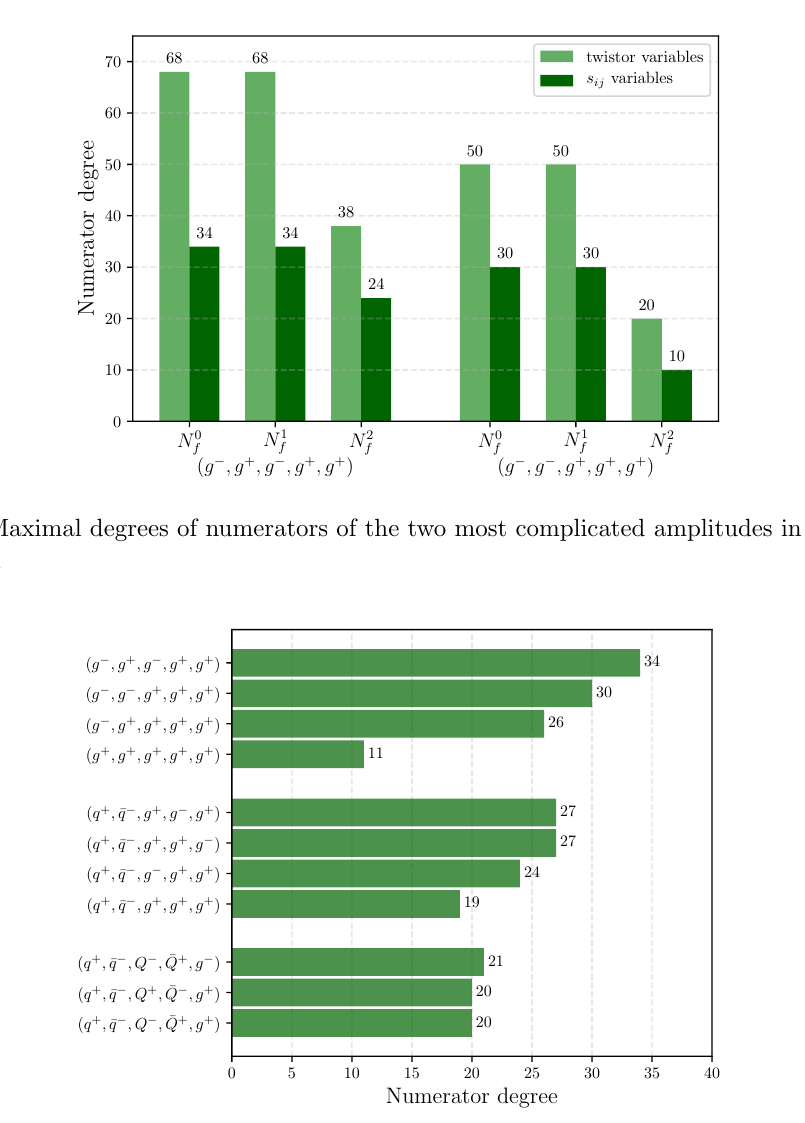
components of the amplitudes in s ij f